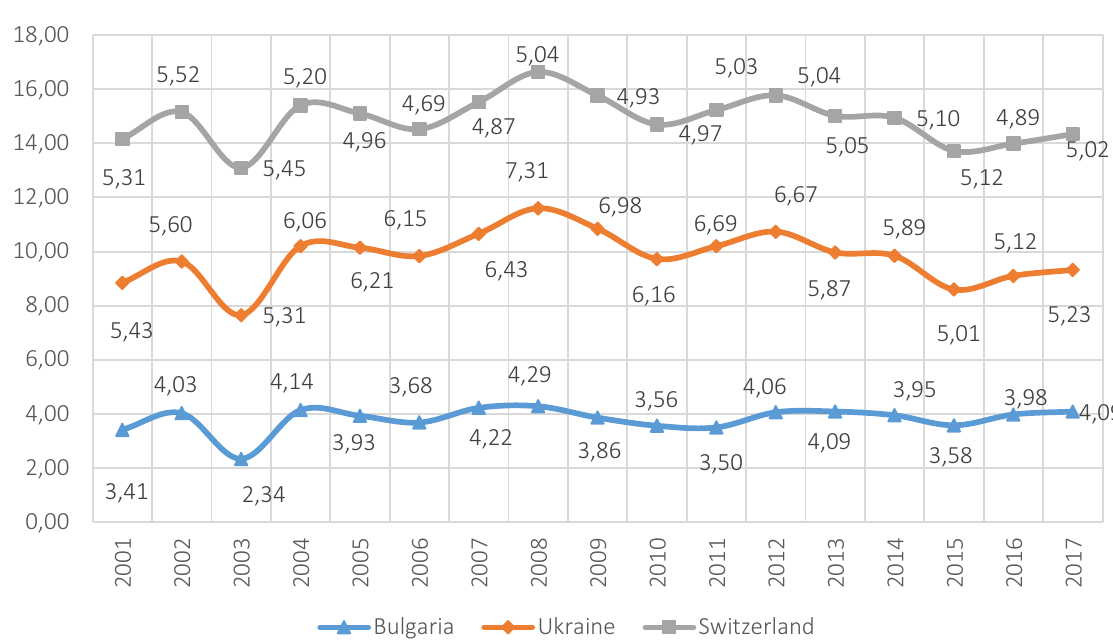
Figure 5. Government expenditure on education, total (% of